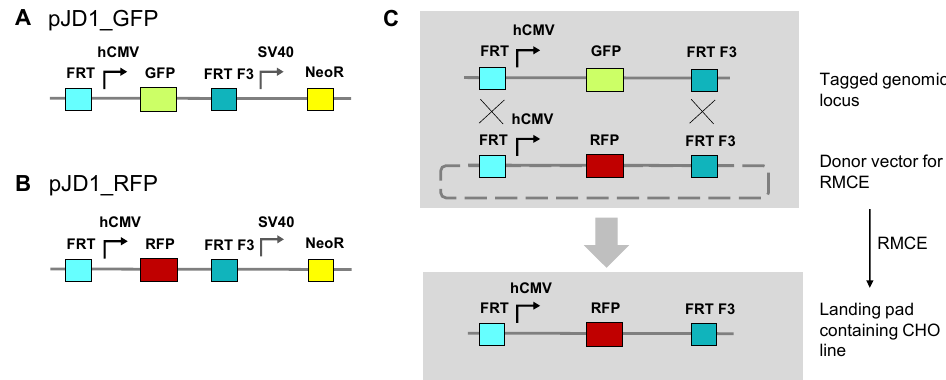
Figure 1. Vector design and process overview for generation of landing pad-containing CHO cell line.